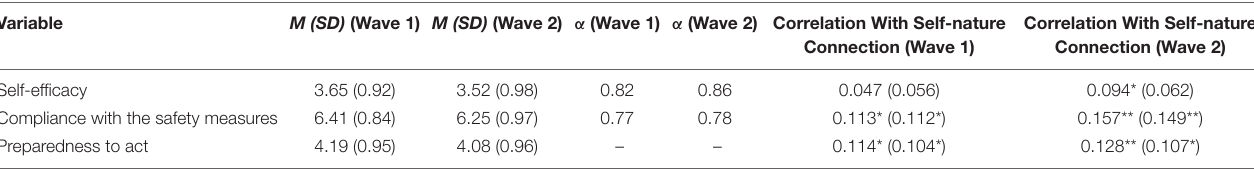
TABLE 5 | Self-efficacy, compliance with the safety measures, preparedness to act, and self-nature connection: Descriptive statistics, reliability coefficients of relevant scales and correlations.